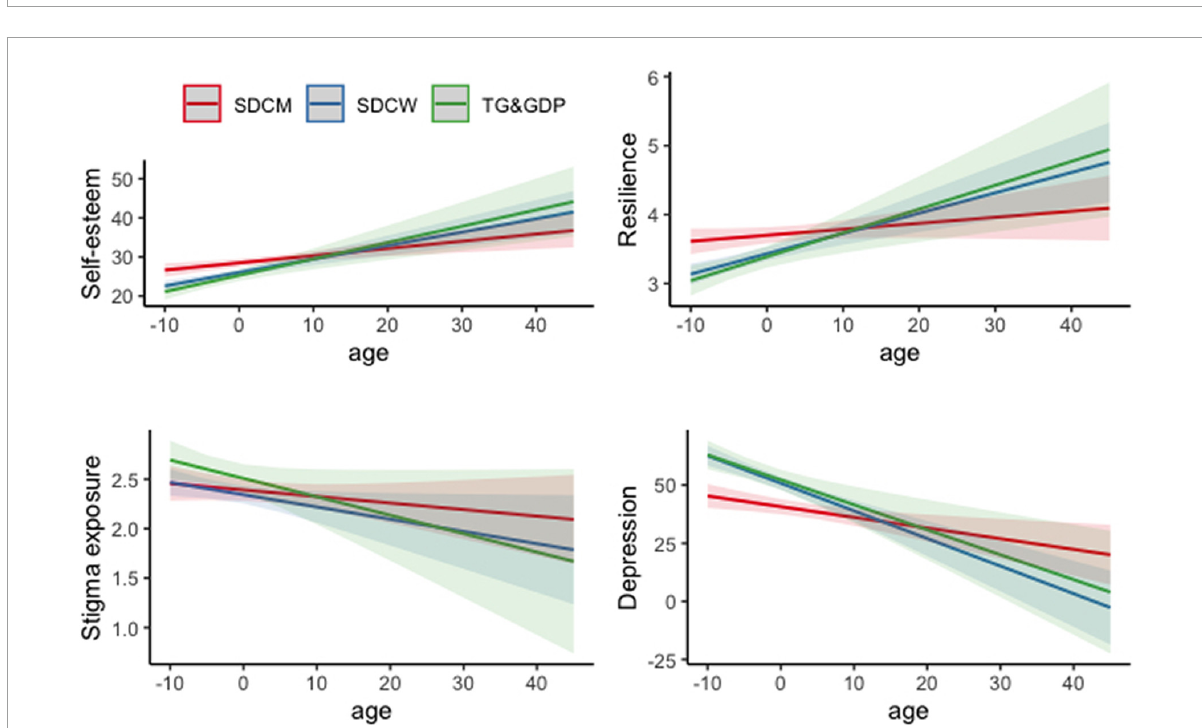
FIGURE2 Interaction plot for age (centered) and separate groups of participants across studied